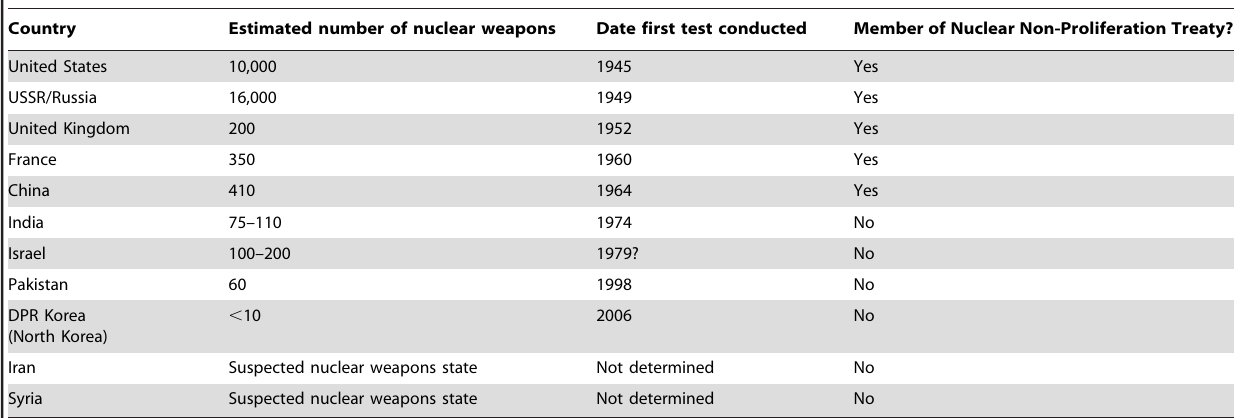
Table 1. Estimated number of nuclear weapons by Country,